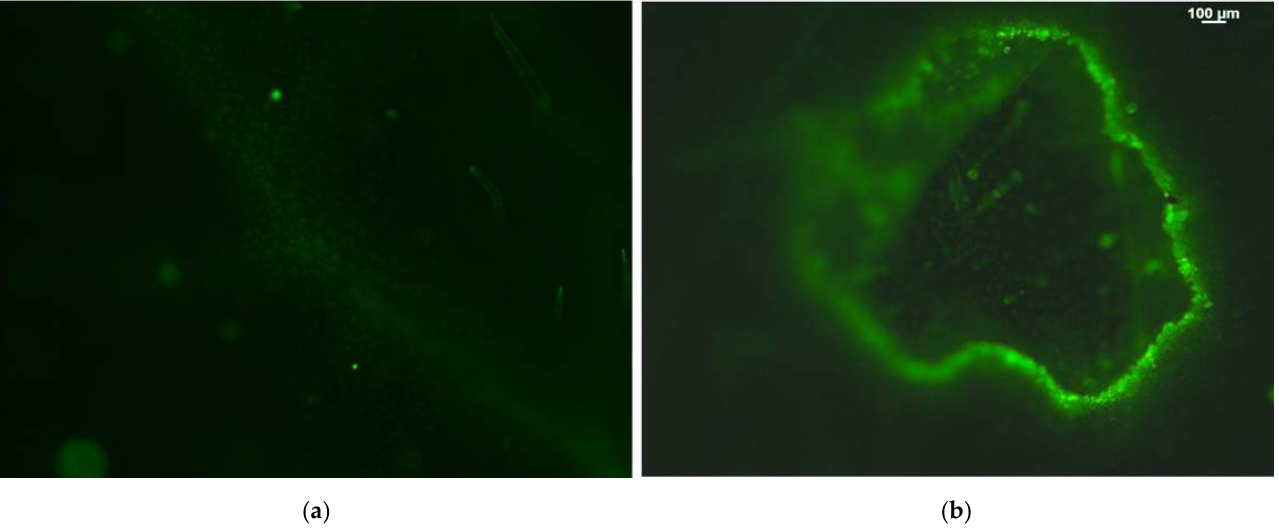
Figure 6. Hydrogen peroxide (H 2 O 2 ) detection by staining of potato leaflets with 2′, 7′-dichlorofluorescein diacetate (DCF-DA) before ( a ) and after ( b ) T. absoluta feeding. The whole area of a feeding zone is shown. Increased generation of hydrogen peroxide is visible by the light green color. Scale Bar: 100 μm.